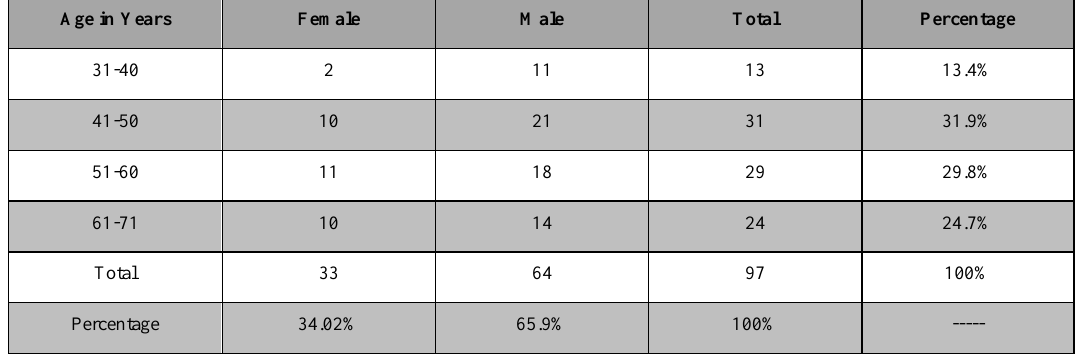
Table 1. Age and sex distribution of Post-COVID-19 fungal infection patients.